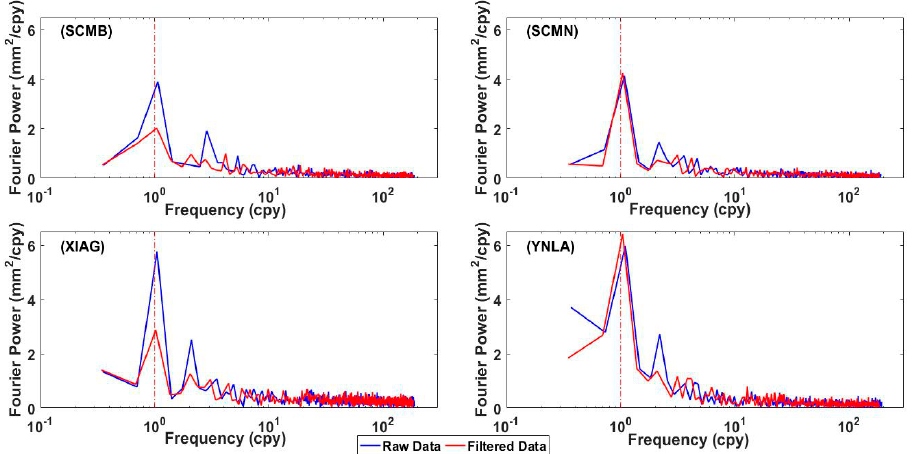
Figure 2. The GPS Fourier power spectra of the unfiltered (blue) and filtered (red) time series for four selected GPS stations (i.e., SCMB, SCMN, XIAG, and YNLA).